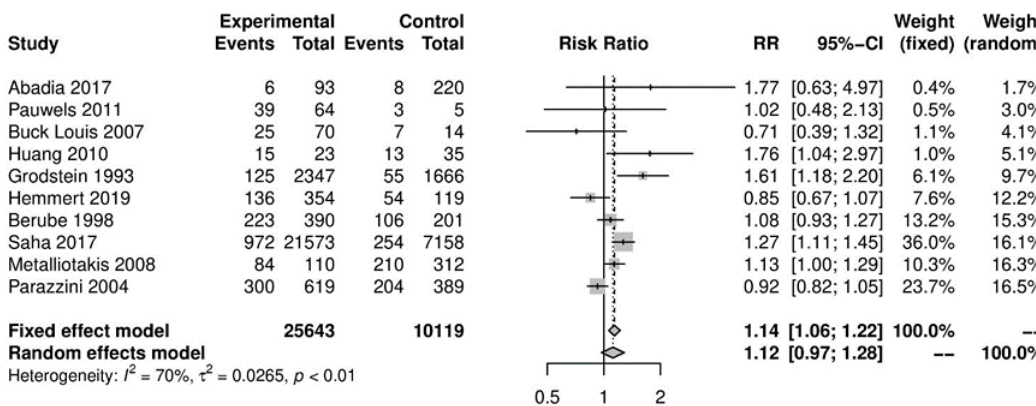
Figure 2. Main analysis of events (endometriosis cases) in caffeine intake group (>100 mg/day) versus little or no caffeine intake (<100 mg/day).